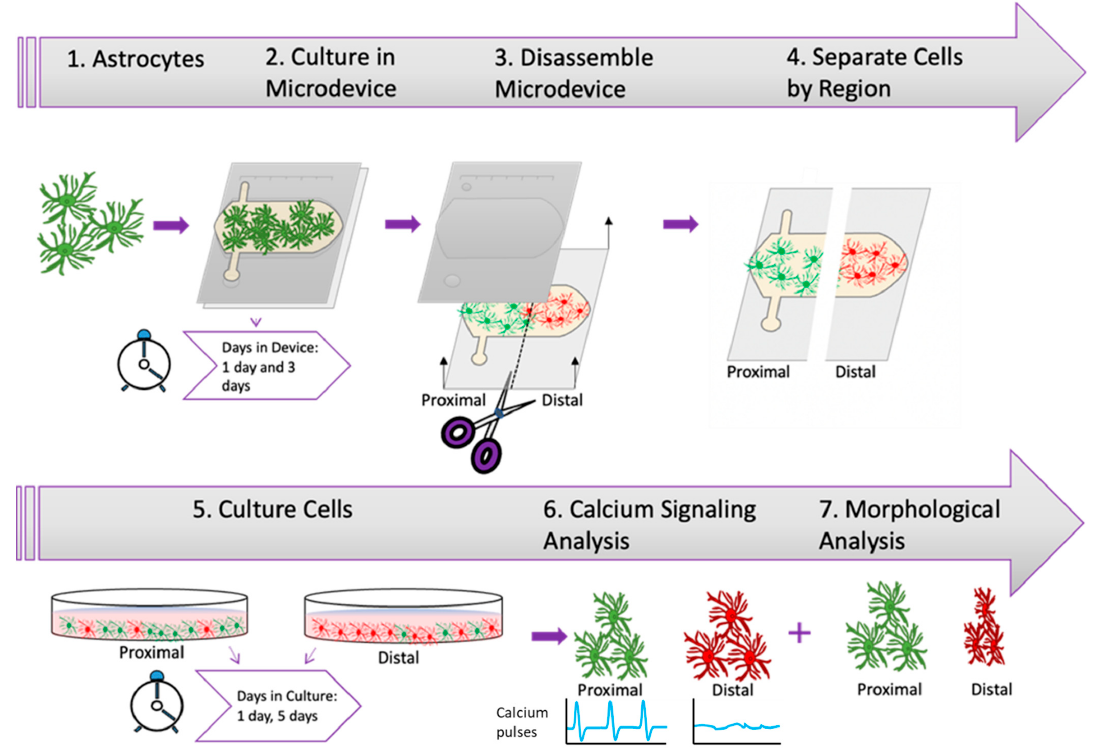
Figure 3. Experimental Design. Illustration depicting experimental timeline beginning with the harvesting of rat astrocytes and culture within microfluidic device at different time periods followed by the extraction of astrocytes from device and culture of astrocytes prior to calcium signaling analysis and morphological analysis.